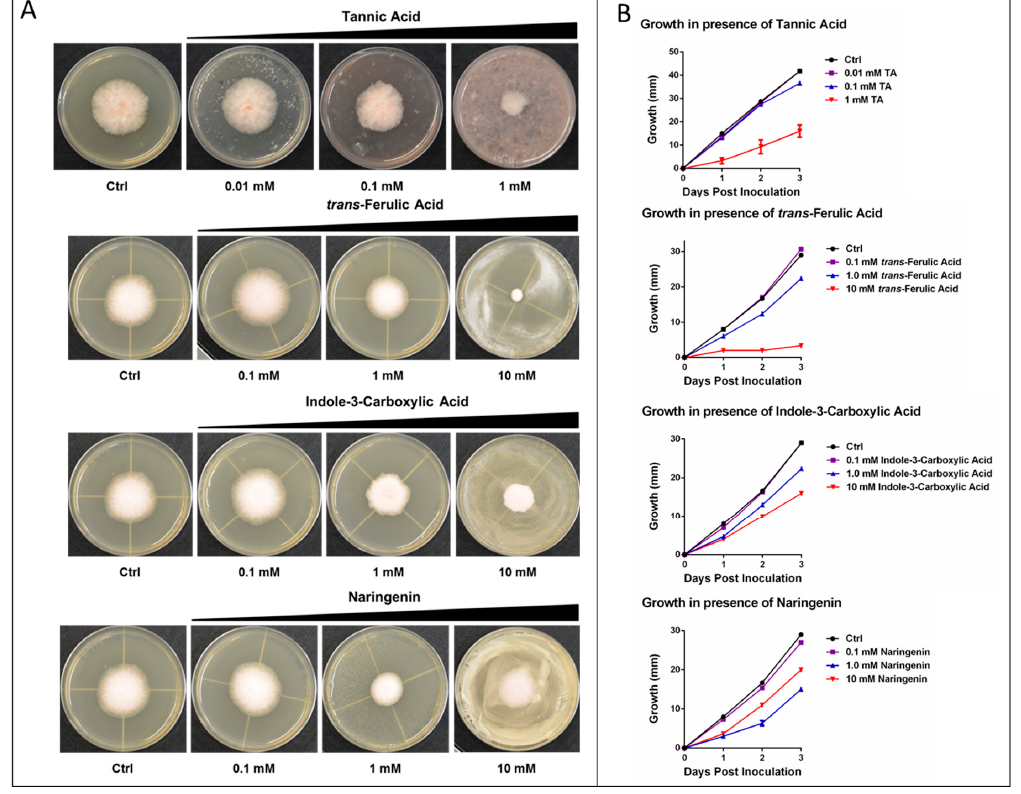
Figure 5. Fungal growth inhibition assay in the presence of increasing metabolite concentrations. ( A ) Radial growth of a fungal colony inoculated at the center of a potato dextrose agar (PDA)